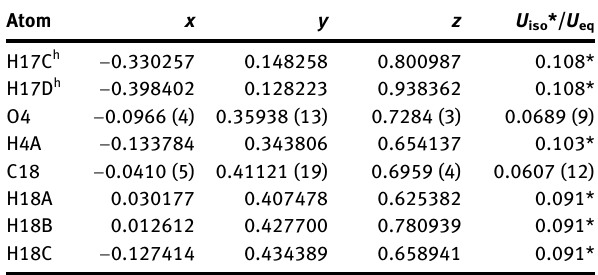
Table  : Fractional atomic coordinates and isotropic or equivalent isotropic displacement parameters (Å 